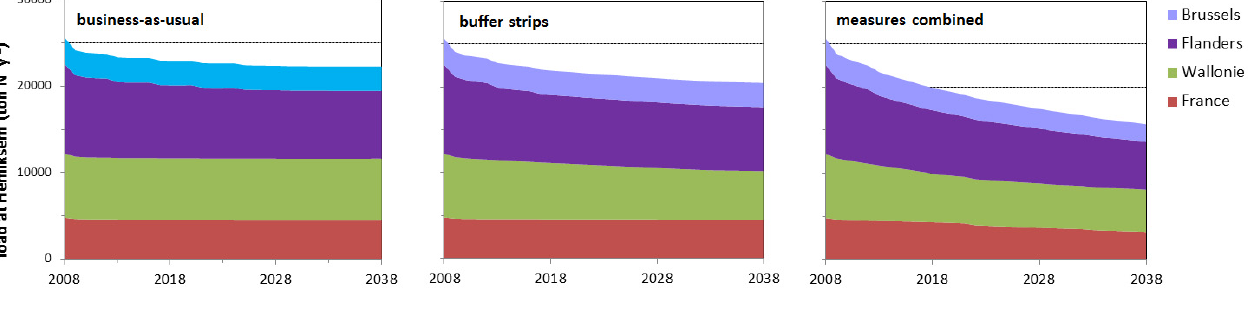
Fig. 8. Regional source apportionment of the nitrogen load of the Scheldt. Sum of the cumulative loads of the four regions exceeds the observed load at Hemiksem by 14–20% (Figs. 4 and 6). This is probably because of uncertain estimates of water exports toward Dunkirk at the French-Belgian border and toward Western Flanders at Gent and the neglection of in-stream retention with these full-catchment instantaneous balance estimates (Olde-Venterink et al. 2003, Billen et al. 2005).